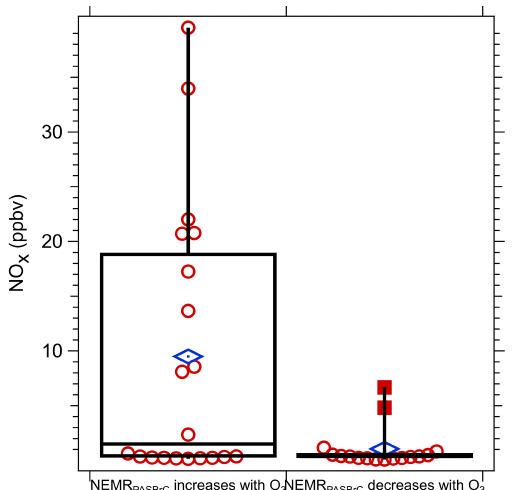
Figure 13. Comparison between the average NO x level across the transect for two groups of data segregated by the NEMR PASBrC having either a positive or negative relationship with O 3 , such as that shown in Fig.